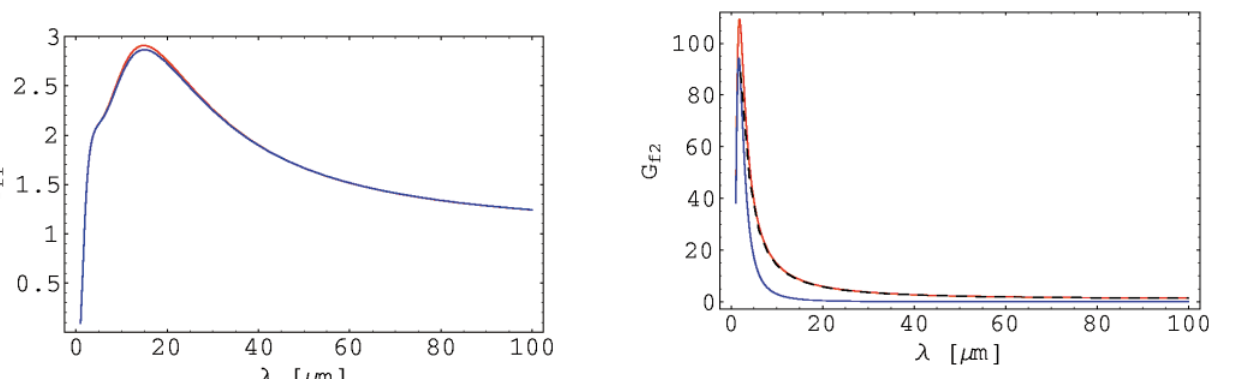
FIG. 4. (Color) BC2 gain G f 2 of density modulation as a func- tion of modulation wavelength at the entrance of BC2 for s d (cid:1) 3 3 10 2 6 , g´ 0 (cid:1) 0 m m, as calculated from Eq. (38) (in red) and the last term of Eq. (38) only (in blue). The dashed curve is the numerical solution of the integral equation found in Ref.